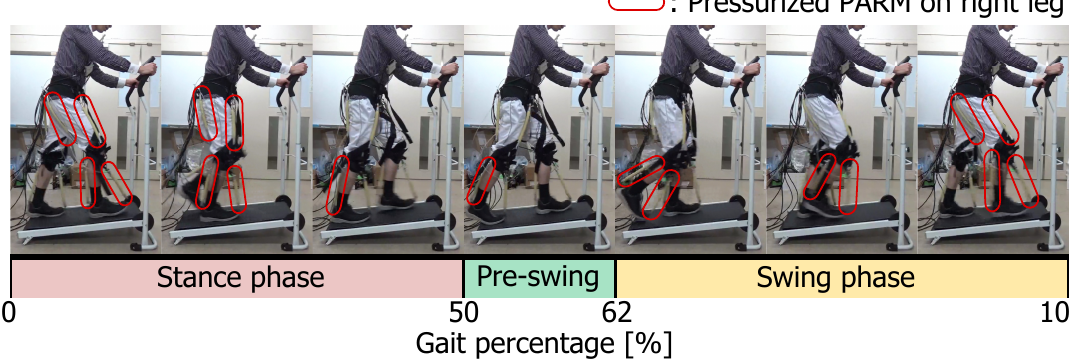
Figure 14. Assisted walking sequence on the treadmill. The trainee wearing the gait assistive suit walked on the treadmill. The horizontal axis shows the gait percentage of the right leg. The red marker means the pressurized PARM on the right